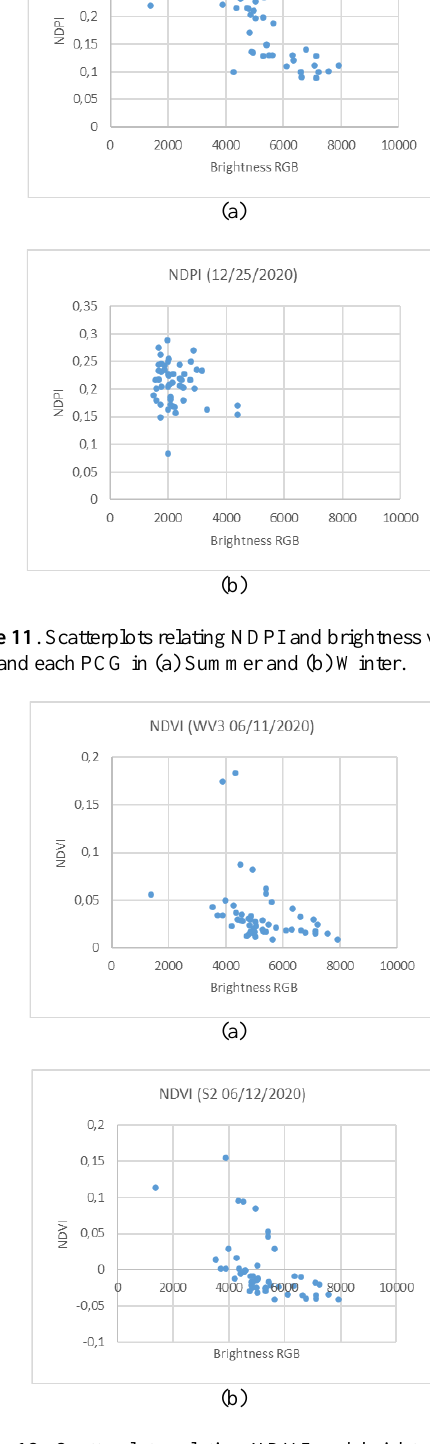
Figure 12 . Scatterplots relating NDVI and brightness values computed on a) WV3 and (b) S2 images for each PCG in